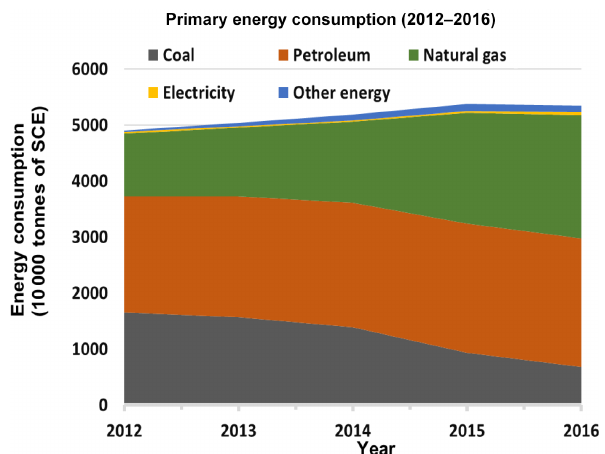
Figure 6. Primary energy consumption in Beijing. Petroleum con- sumption remained stable (21–23 million tonnes of coal equiva- lent (Mtce)) over the years while natural gas and primary electric power increased significantly by a factor of 1.8 and reached 23Mtce in 2016. Coal consumption declined remarkably by 56.4% from 15.7Mtce in 2013 to 6.8Mtce in 2016. The proportion of coal in primary energy consumption in 2016 was 9.8%, within its target of 10% set by the Beijing government. Note electricity here represents primary